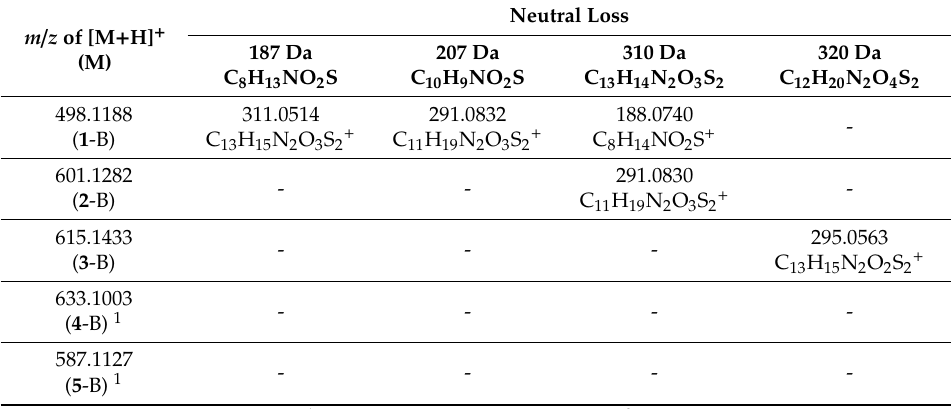
Table 12. Selected NLs recorded during MS 2 experiments for the B isomers of the novel derivatives of Ybt by application of LC-HRMS. All recorded fragmentation spectra are shown in the Supplementary Material. The resulting fragments [M-X + H] + caused by the specific NL [X] listed on top of the columns are noted in the table